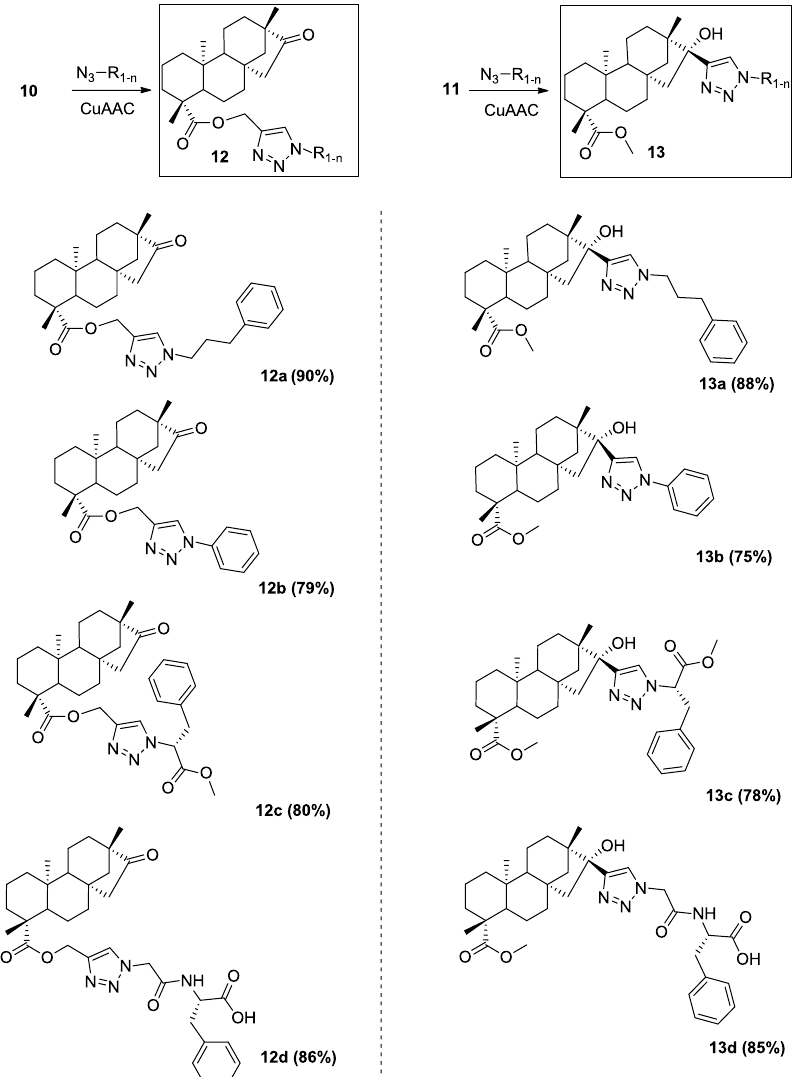
Scheme 2. Synthetic isosteviol triazole